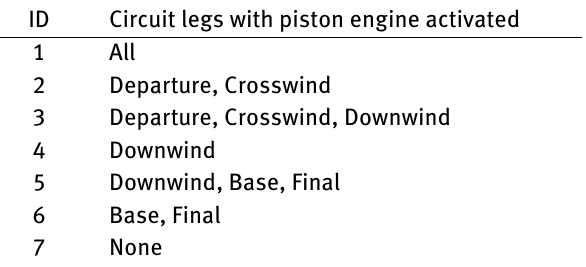
Table 6: Piston engine conditional activation